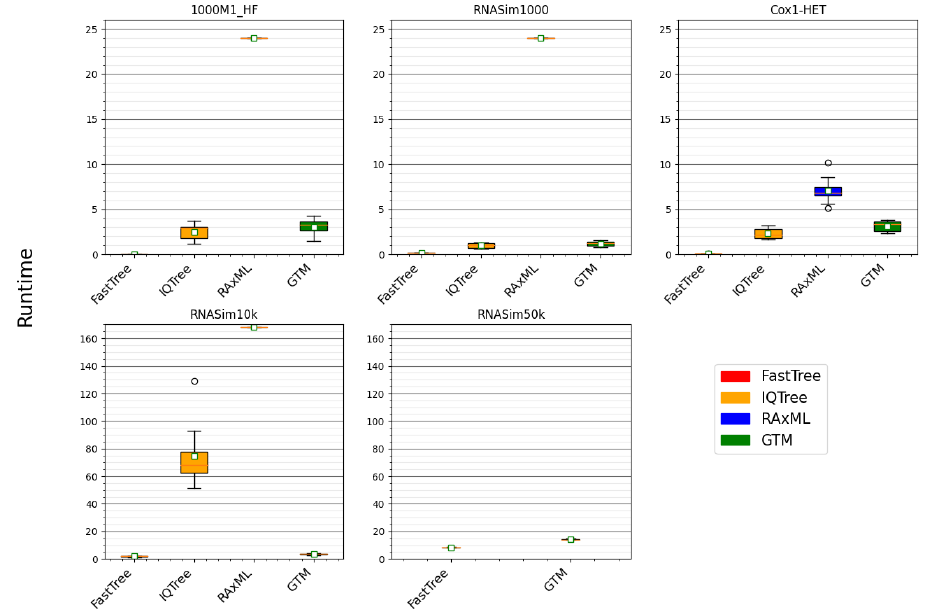
Figure 3. Comparing the GTM pipeline to ML methods for running time. Here, we show the runtime (hours) of computing the trees using three different ML methods and a GTM pipeline. For the 1000M1-HF, RNASim1000, and Cox1-HET datasetes, the GTM pipeline uses IQ-TREE starting tree, IQ-TREE constraint trees, and IQ-TREE guide tree. For the RNASim10k and RNASim50k datasets, the GTM pipeline uses FastTree starting tree, IQ-TREE constraint trees, and FastTree guide tree. All of the ML methods were given true alignments and allowed to run to completion except for RAxML, which was limited to 24 h on the 1000M1-HF, RNASim1000, and Cox1-HET datasets, and limited to 168 h on the RNASim10k and RNASim50k datasets. On the RNASim50k datasets, the IQ-TREE failed to return a tree and RAxML returned a tree with an error rate of 100%, and so results for RAxML and IQ-TREE are not shown for that